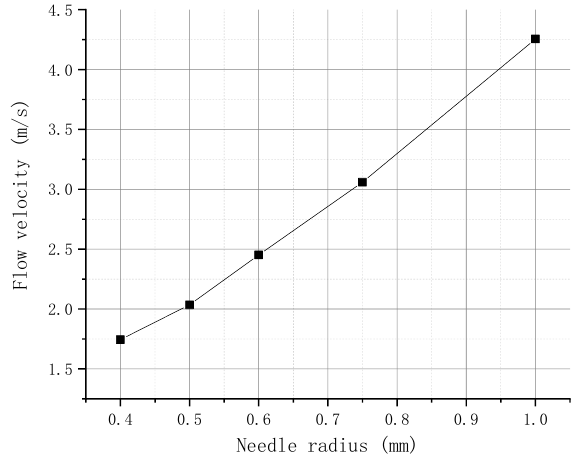
Figure 7. Flow velocity in different needle radii.